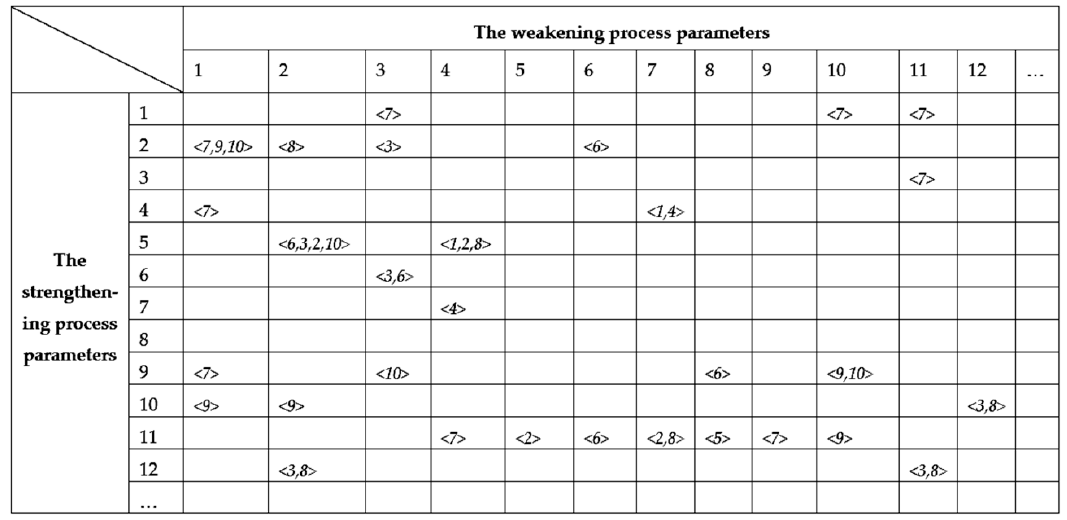
Figure A1. Welding process contradiction matrix. Table A1. Contradiction parameters of welding process.